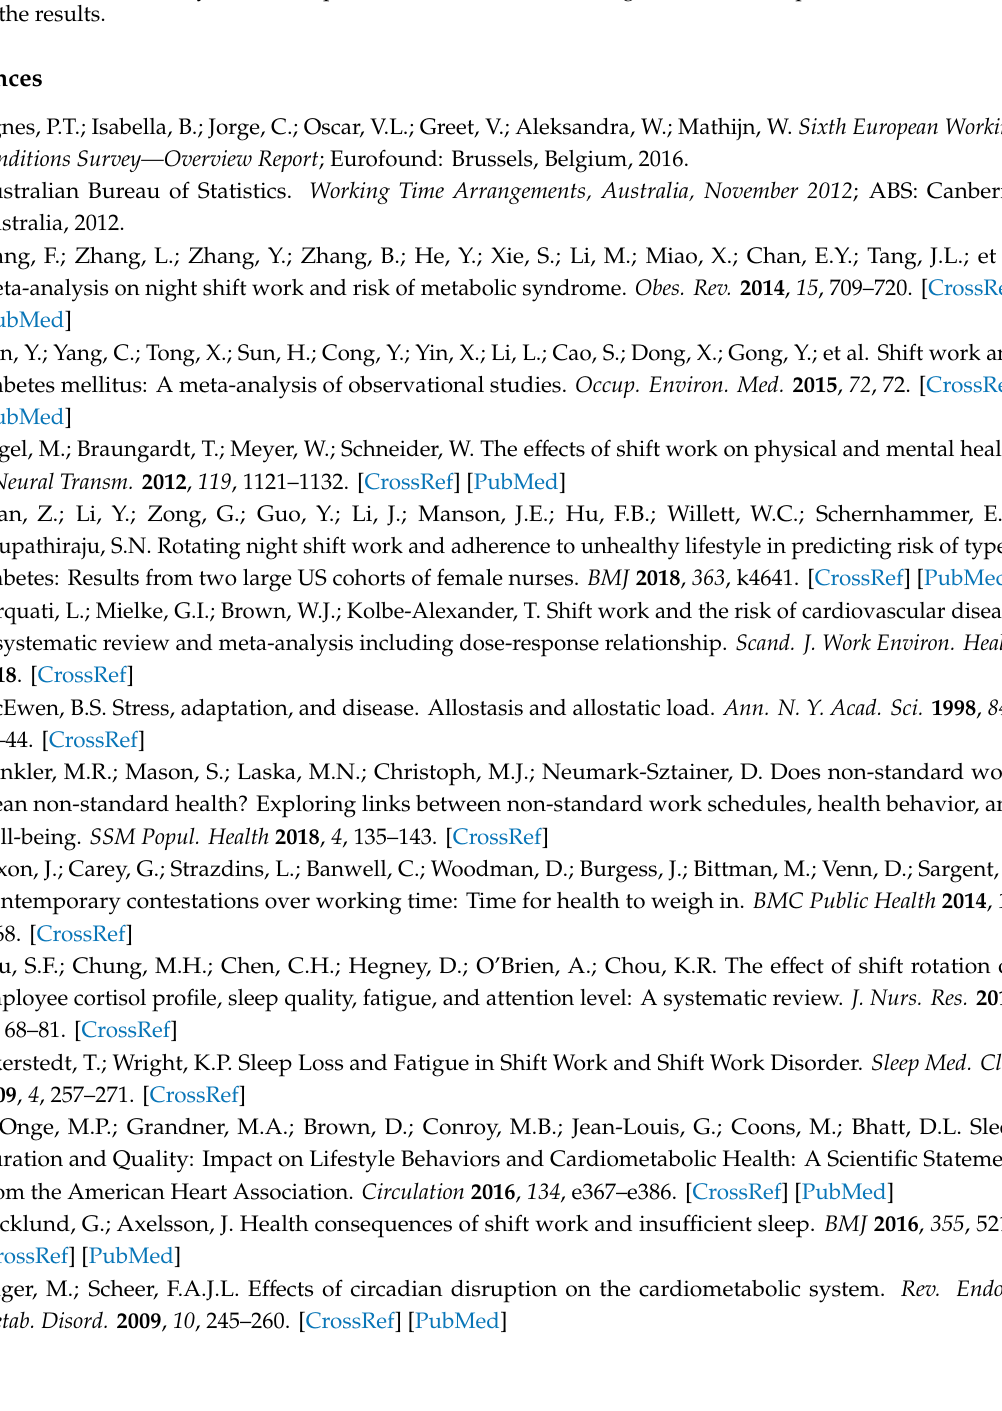
Figure S1: Recruitment advertisements, Table S1: Screening questions for diet quality, Table